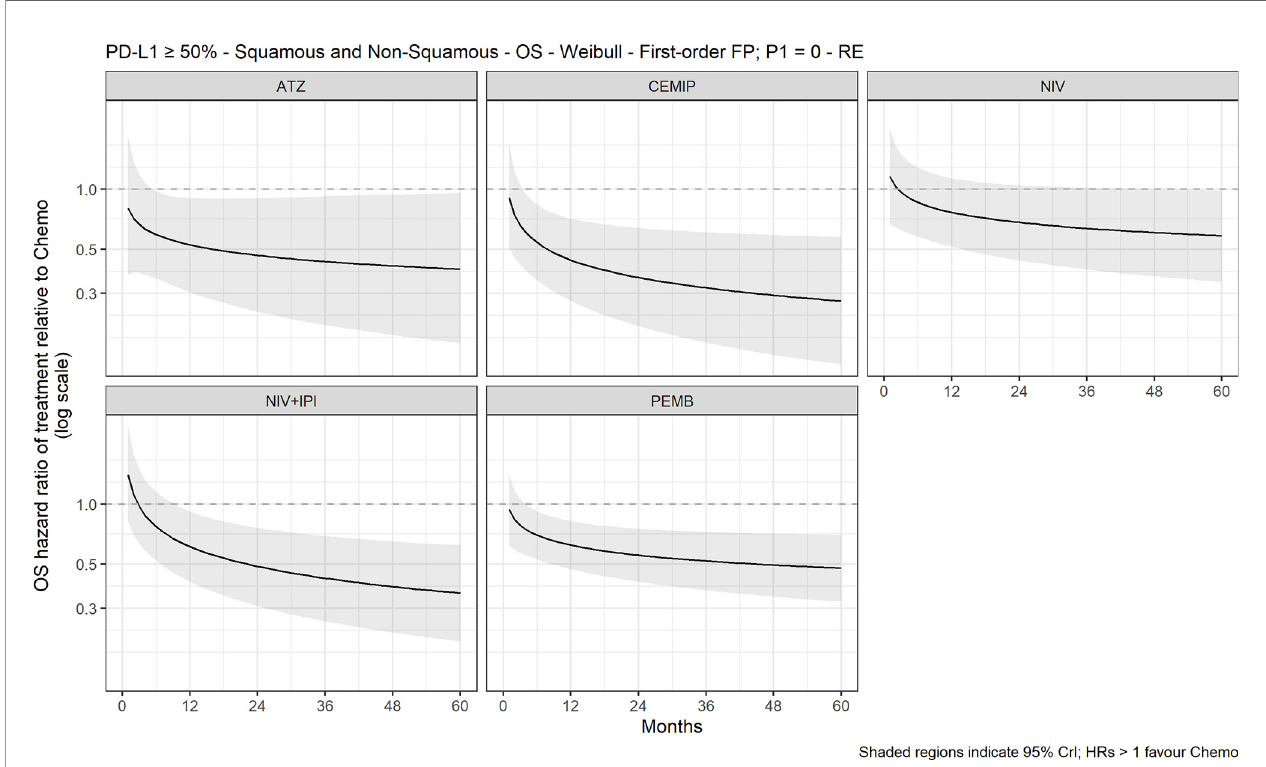
FIGURE 3 | Expected OS HR over time for cancer immunotherapy versus chemotherapy with 95% CrI, mixed histology (60-month time horizon). ATZ, atezolizumab; CEMIP, cemiplimab; chemo, chemotherapy; Diff., difference; HR, hazard ratio; NIV, nivolumab; NIV+IPI, nivolumab plus ipilimumab; OS, overall survival; PD-L1, programmed death-ligand 1; PEMB, pembrolizumab; FP, fractional polynomial, P1=0, Weibull. RE, random